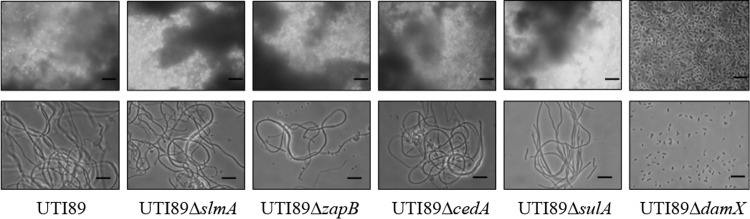
Strain UTI89ΔdamX was unable to demonstrate secondary infection or filamentation on urine exposure. Flow chamber-based infection of the PD07i bladder cell line was carried out with strains UTI89wt, UTI89ΔslmA, UTI89ΔzapB, UTI89ΔcedA, UTI89ΔsulA, and UTI89ΔdamX. Panels in the top row represent secondary infection and biofilm formation (cloudy appearance) on exposure to concentrated urine, and the bottom row depicts bacteria flushed out of the flow chambers after 22 h of concentrated urine exposure. Scale bars, 20 µm.